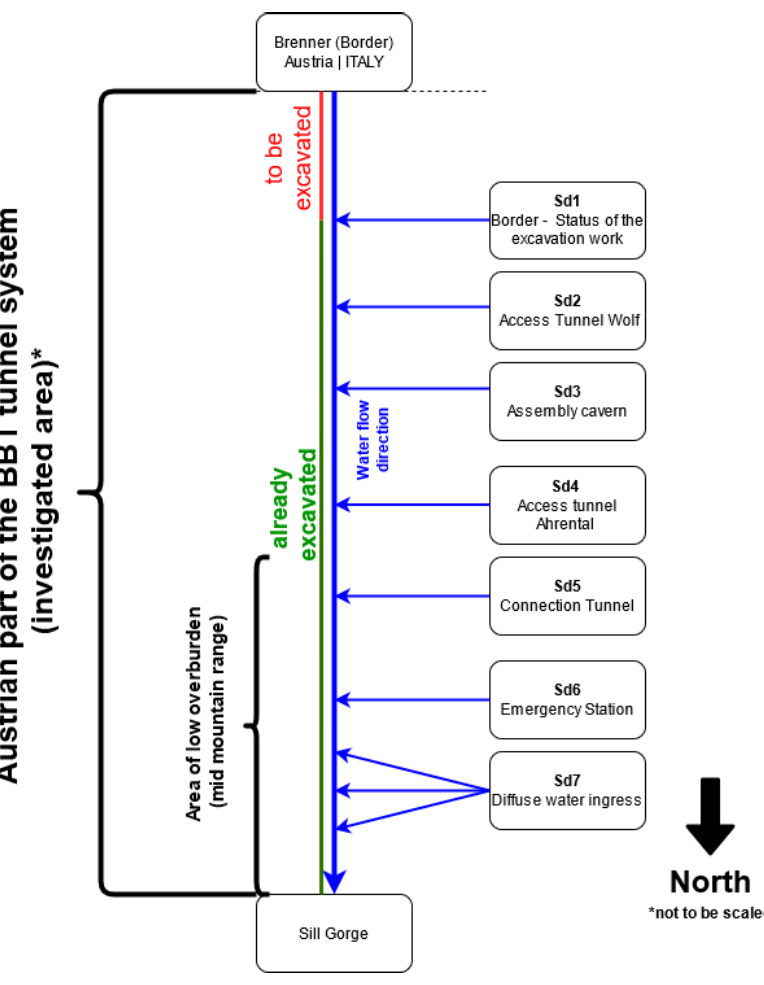
Figure 4. Tunnel water discharge system at the Austrian section of the BBT (* not to be scaled).